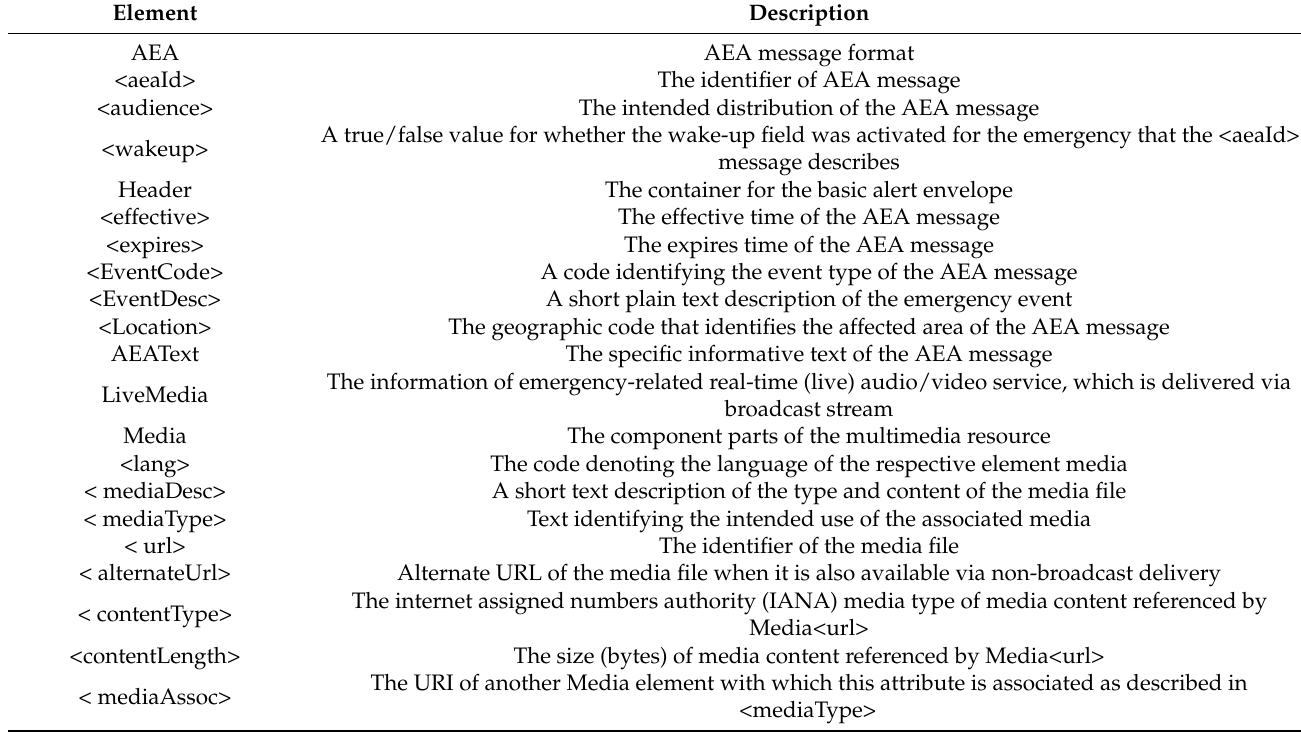
Table 1. The description of the AEAT elements.